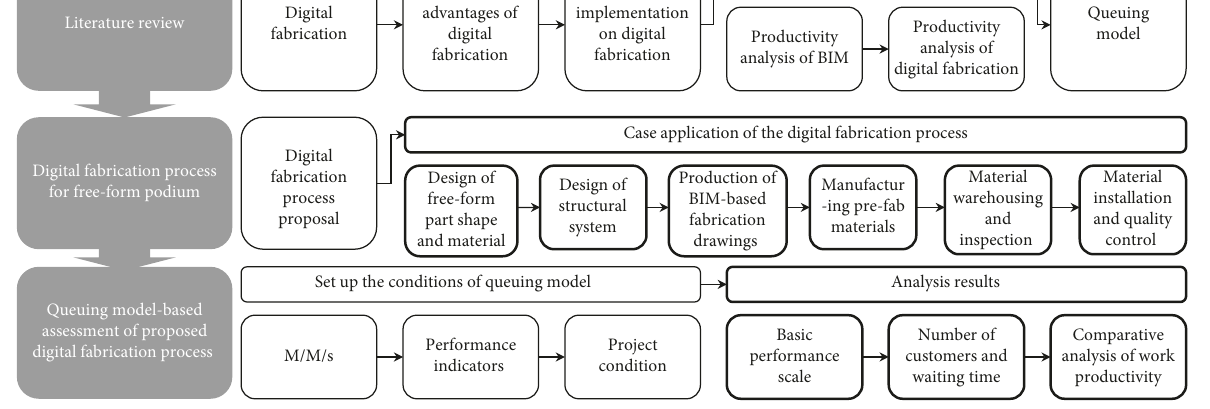
Figure 1: Research